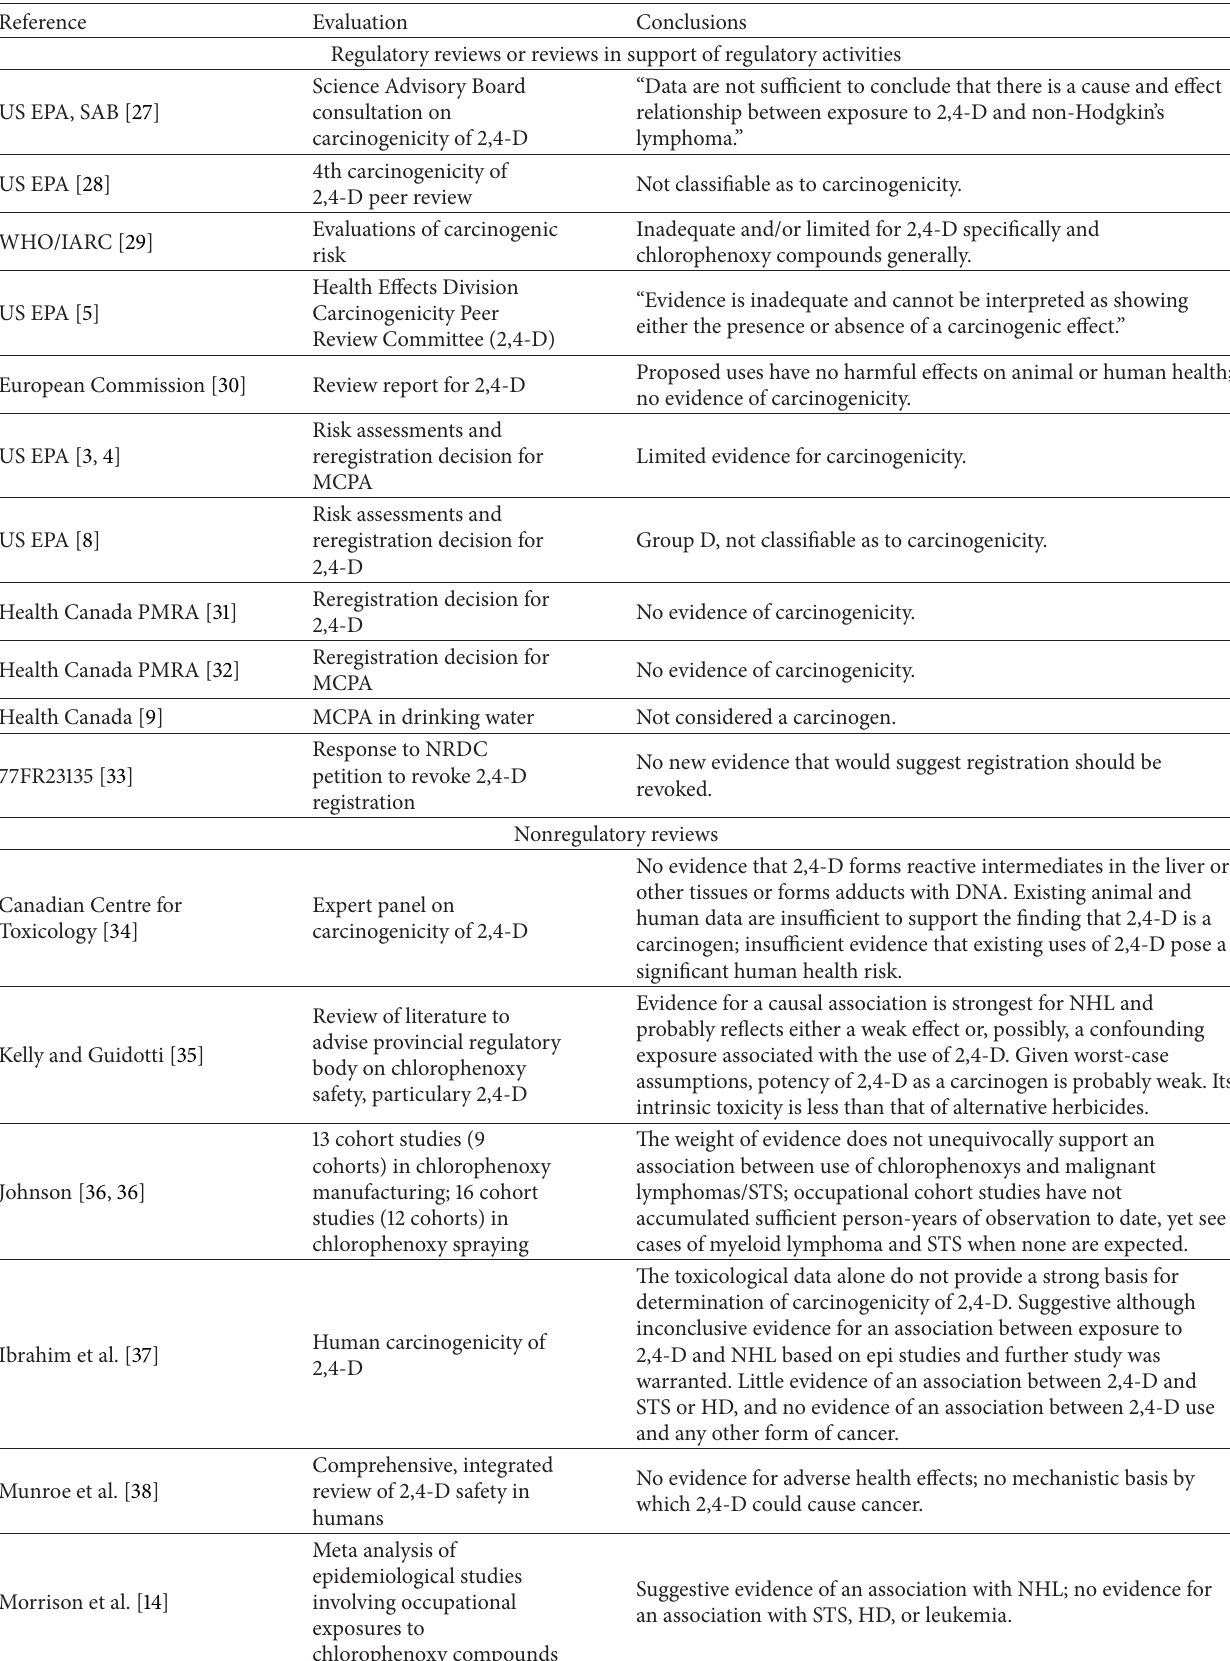
Table 1: Summary of reviews of 2,4-D and/or